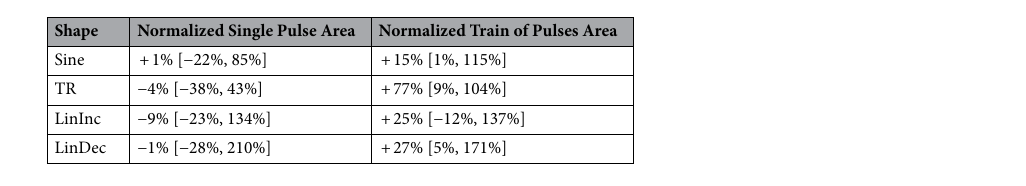
Table 2. Median and quartiles for normalized change in sensation